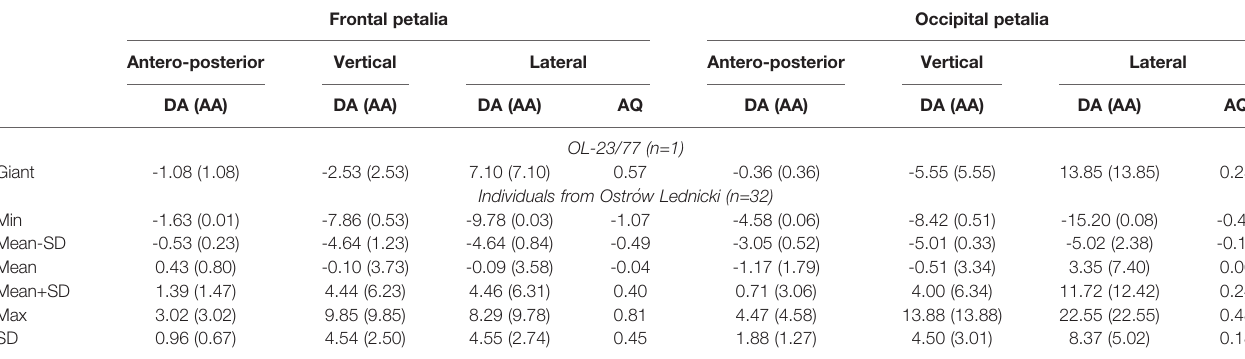
TABLE 3 | Directional and absolute asymmetry of the frontal and occipital